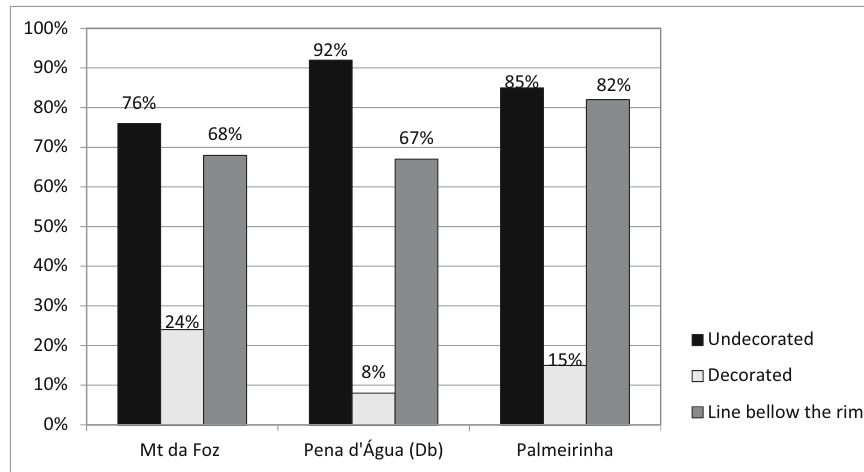
Figure 7: Initial Middle Neolithic. Undecorated versus decorated pottery and the percentage presence of decorated vessels with an incised line below the rim ( according to Carvalho, 2016; Neves, 2010; Silva et al., 2010 )